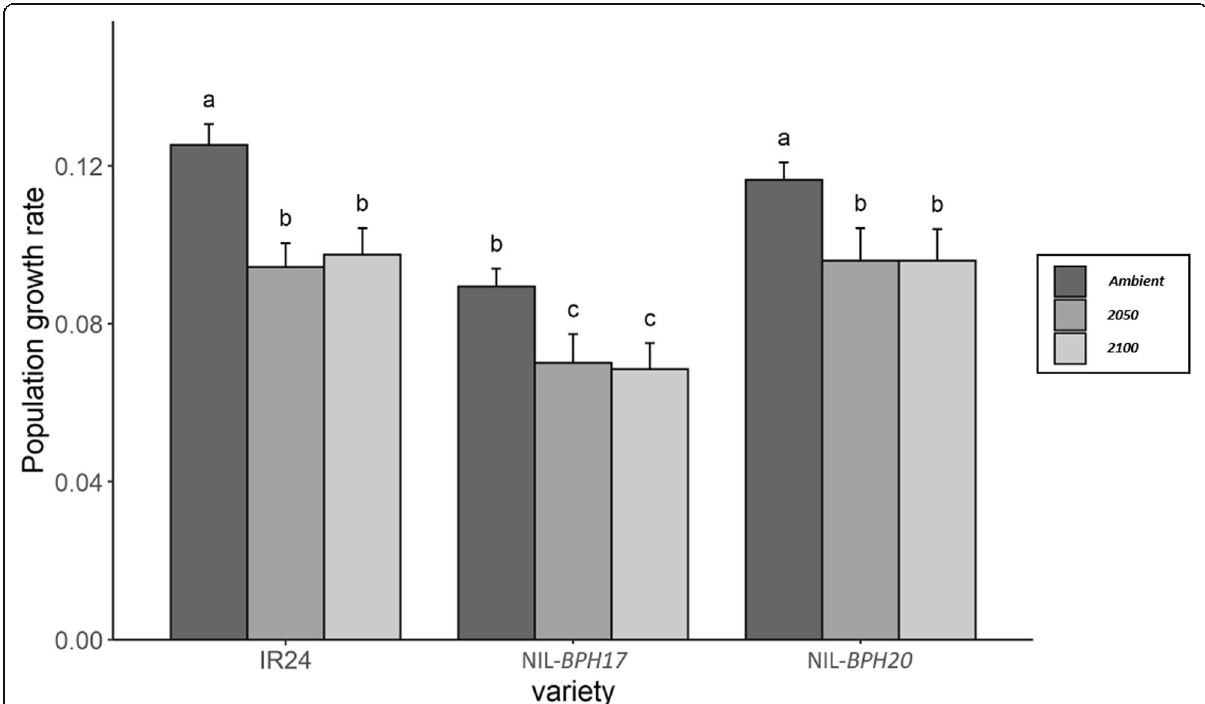
Fig. 3 The population growth rate of N. lugens nymphs feeding on IR24 and NILs under different environments. a IR24 and NIL- BPH17 . b IR24 and NIL- BPH20 . Means in each column followed by a different letter differ significantly ( P <